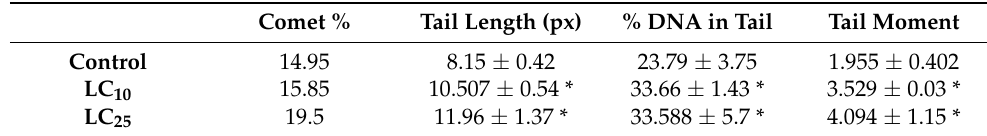
Table 2. DNA breaks after SeNPs exposure to B. alexandrina snails.